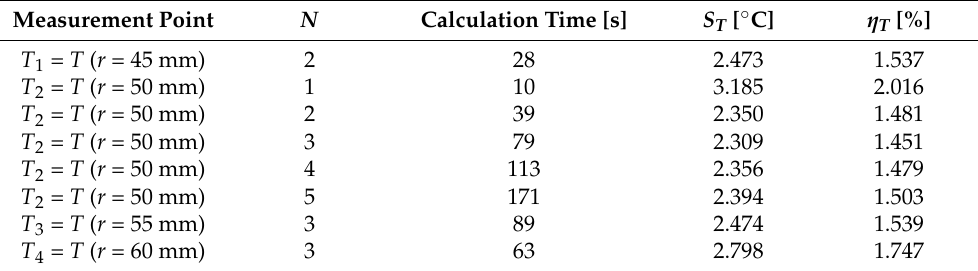
Table 4. Calculation time and errors obtained by the AMI method for different measurement points.